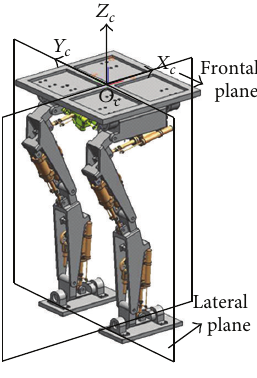
Figure 3: The diagram of the motion